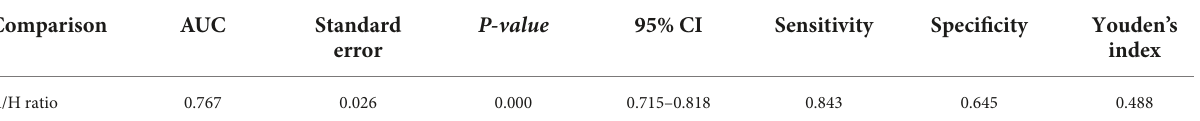
TABLE 5 Receiver operating characteristic (ROC) analysis values of A/H